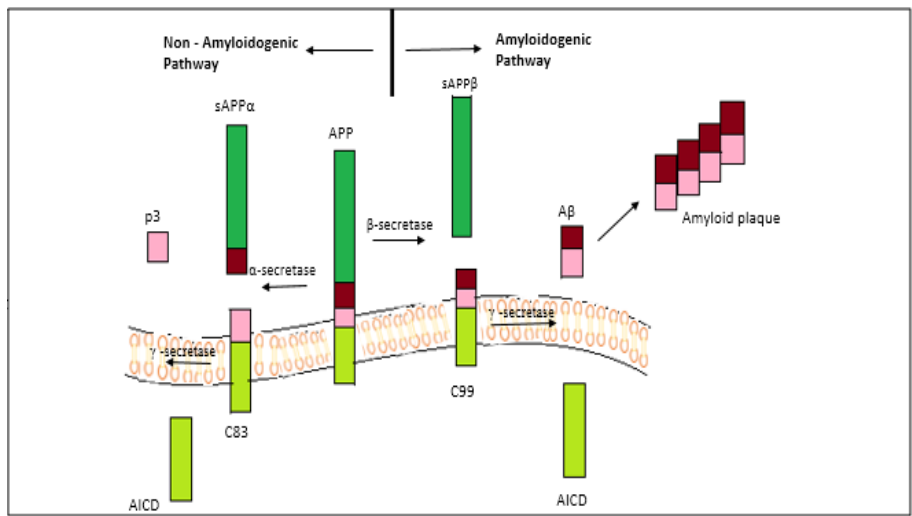
Figure 1. Amyloid precursor protein (APP) cleavage in normal (non-amyloidogenic) and AD (amyloidogenic) pathways.